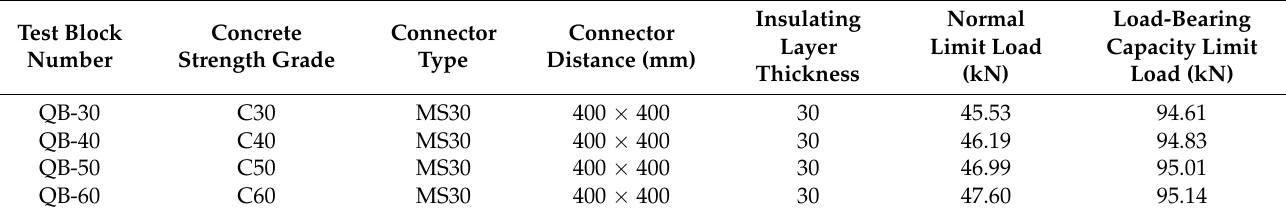
Table 8. Ultimate load of concrete connectors of different strength grades